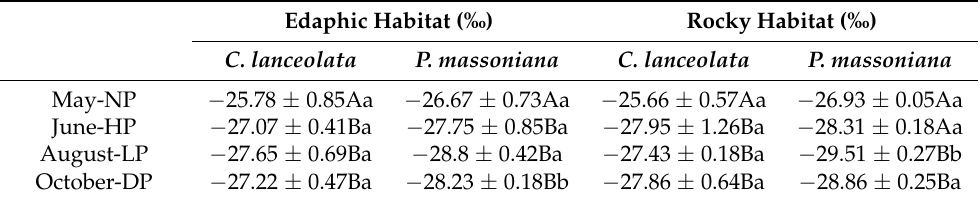
Table 4. Comparisons of δ 13 C values of C. lanceolata and P. massoniana in edaphic and rocky